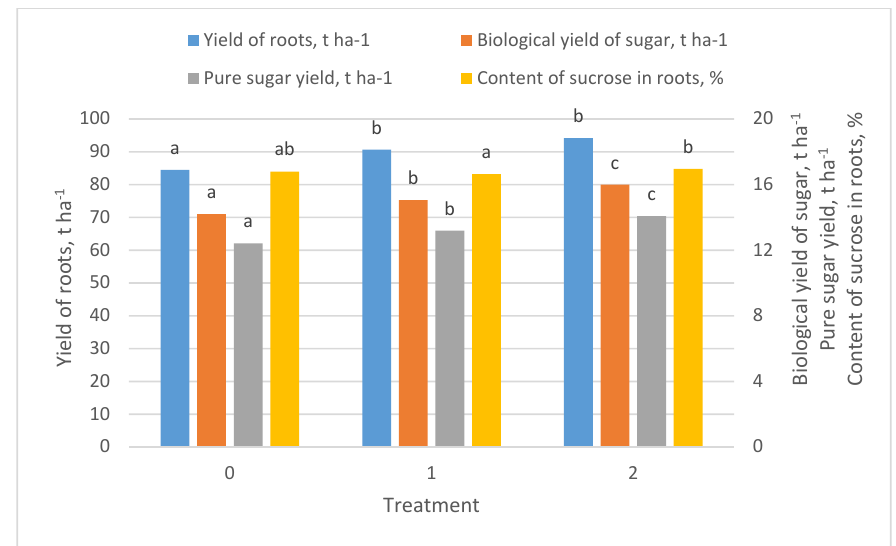
Figure 2. The influence of Penergetic activators and Azoter bacterial preparation on the yield of roots, sugar yield, and sucrose content (2017–2019). (The same letters under the columns in the same color indicate a lack of significant differences between means at α = 0.05). Table 6. Descriptive statistics for all experiments with sugar beet (2017–2019). Trait